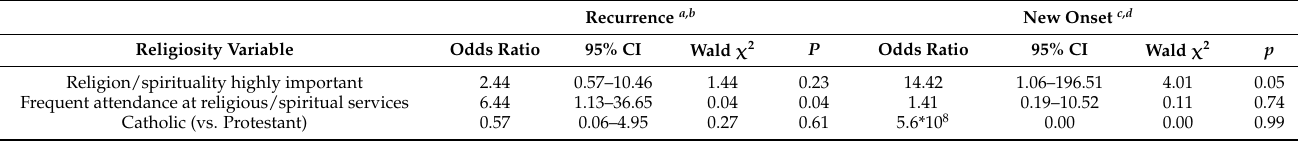
Table 3. Odds ratios of recurrence and new onset of Major Depressive Disorder in 79 adult offspring of depressed and non-depressed parents between 20- and 25/30 year follow ups associated with religiosity variables at year